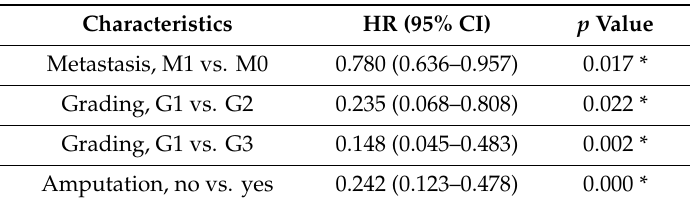
Table 3. Univariate Cox regression of cumulative survival according to Figure 1. HR = Hazard Ratio, CI = Confidence Interval. * p ≤ 0.05.